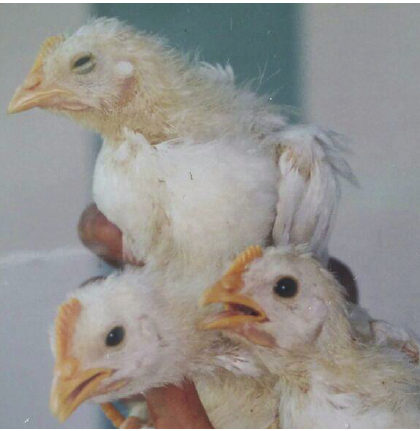
Figure 1: Dullness exhibited in chickens infected following experi- mental infection with IBV (courtesy: Siti Suri